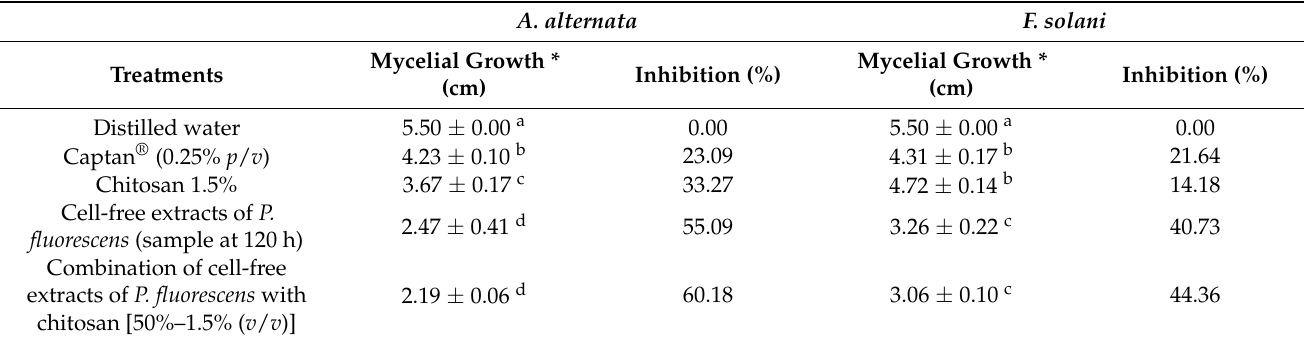
Table 3. In vitro antifungal activity of the cell-free extracts of P. fluorescens and chitosan, alone and combined, on A. alternata and F. solani development.